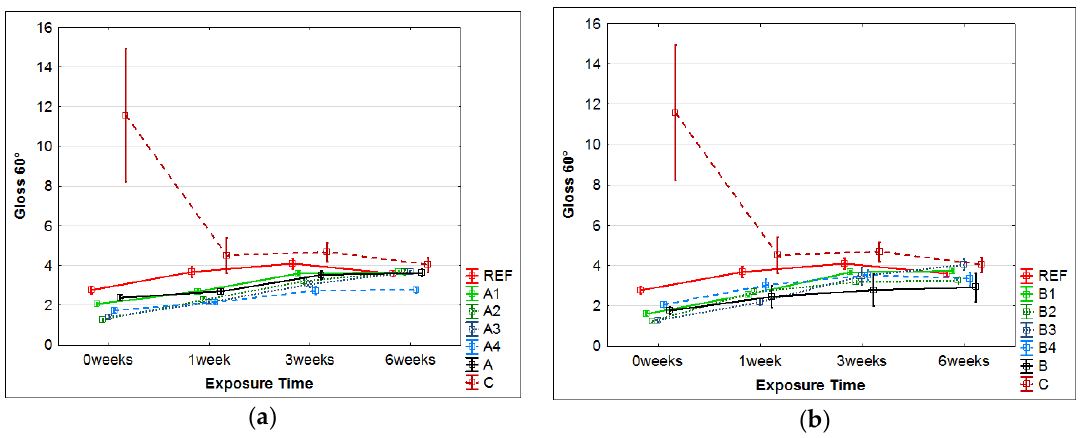
Figure 5. Gloss changes of tested coatings during 6 weeks of artificial weathering. REF: native untreated oak wood; A: oak wood with the nano-based hydrophobic coating; B: oak wood with the hydrophobic coating with wax additives; 1, 2, 3, 4: the types of oak wood surface treatments; C: oil-based coating. ( a ) Relativelly small gloss changes of hydrophobic coating (A) with different surface treatments of oak wood (No. 1–4—see Tables 1 and 2); ( b ) Relativelly small gloss changes of hydrophobic coating (B) with different surface treatments of oak wood (No. 1–4). Comparison with untreated oak wood (REF—similar trends) and oil-based coating (C—high decrease of gloss after 1 week of accelerated weathering) is shown.